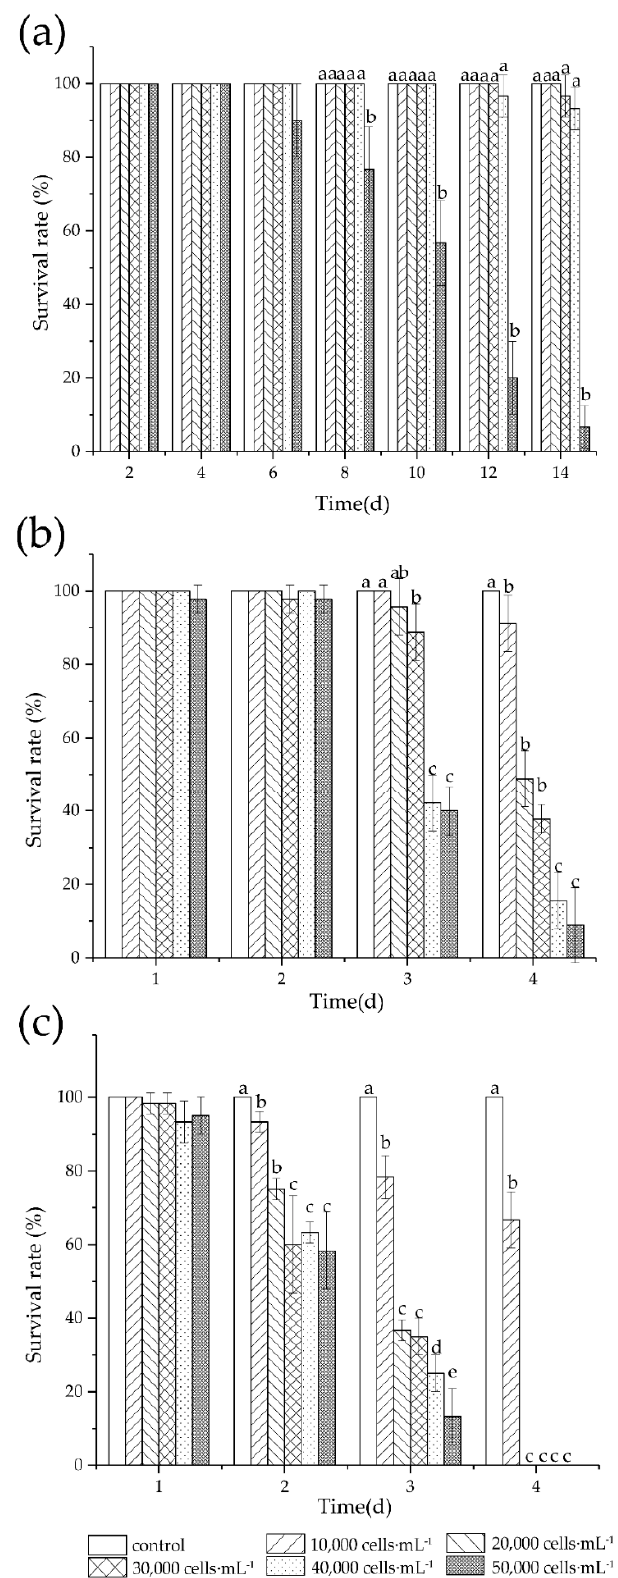
Figure 1. The survival rates of copepod T. japonicus adult female ( a ), copepodite ( b ), and nauplii ( c ) exposed to K. mikimotoi. (mean ± SD, n = 3). Error bars represent SD. Different letters indicate a significant difference among groups at p < 0.05.